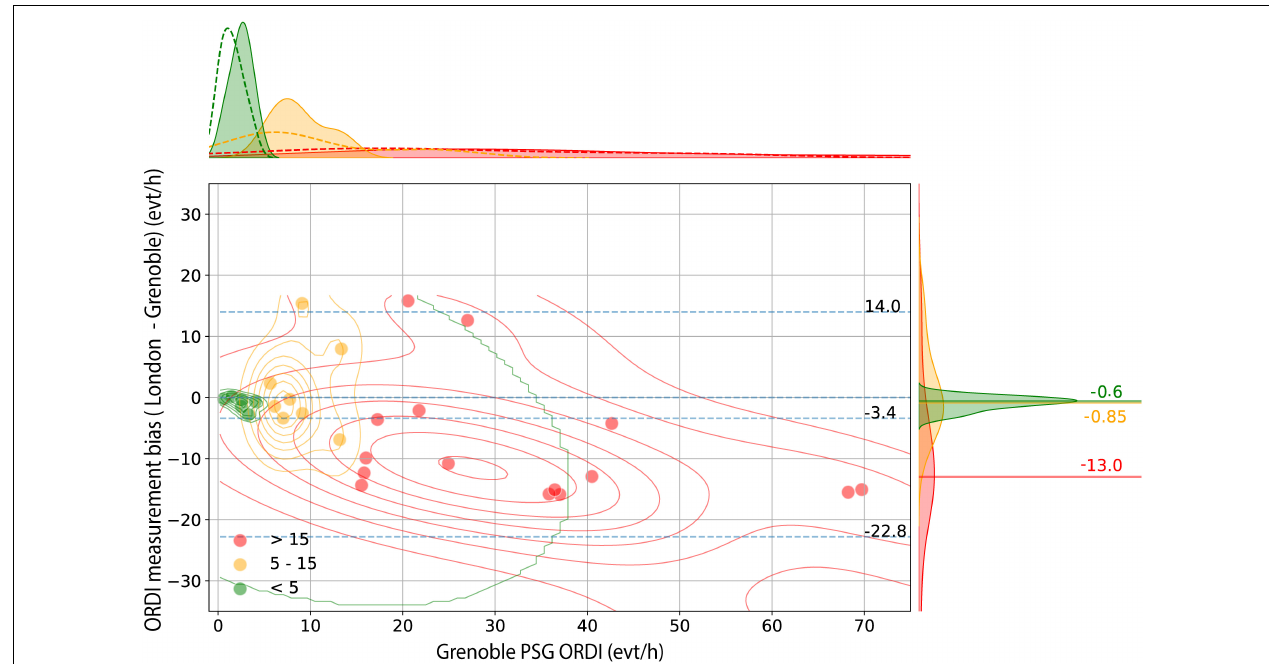
FIGURE 2 | Bland-Altman analysis for London PSG-ORDI versus Grenoble PSG-ORDI. Bland-Altman plot shows the disagreement between average PSG-ORDI (London) and PSG-ORDI (Grenoble) (y axis) as a function of Grenoble PSG-ORDI (x axis), with individual cases stratified into three clinical groups. Bidimensional kernel density estimation plots are superimposed to show the joint distribution of measurement bias within each subgroup. The blue horizontal lines indicate the median, lower and upper bound (5th and 95th centiles) of the measurement bias in the whole sample. The distribution of the disagreement between the 2 methods, stratified by group, is shown on the right, with 3 horizontal lines indicating the median bias within each group. PSG: polysomnography; ORDI: obstructive respiratory disturbance